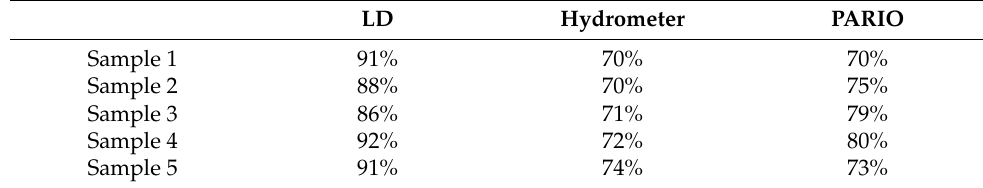
Table A3. Representation of the particles smaller than 50 µ m obtained by three tested methods.